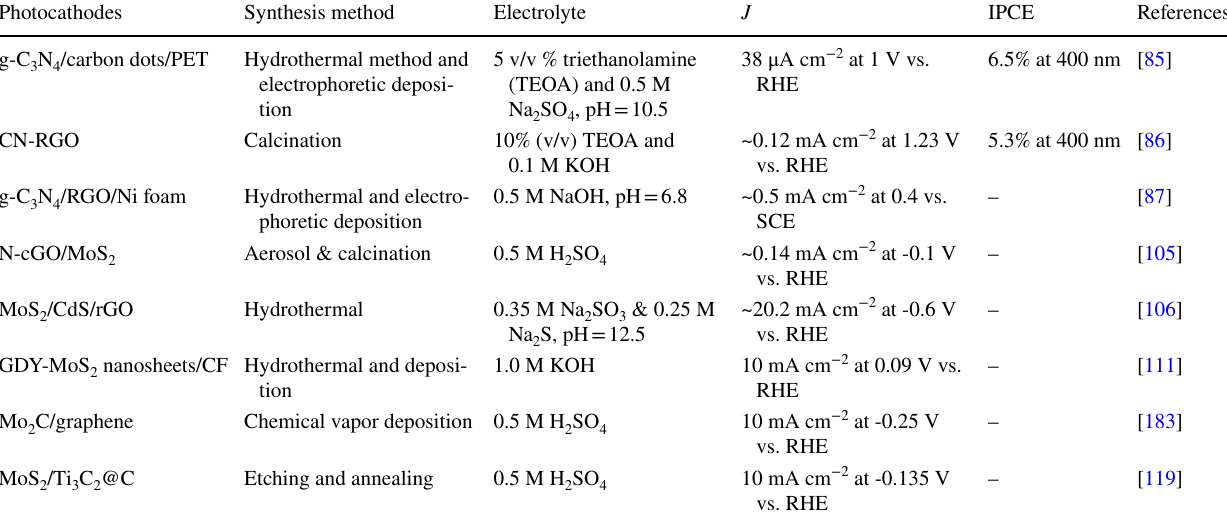
Table 1 Comparison of PEC-HER activity of various 2D photocathodes